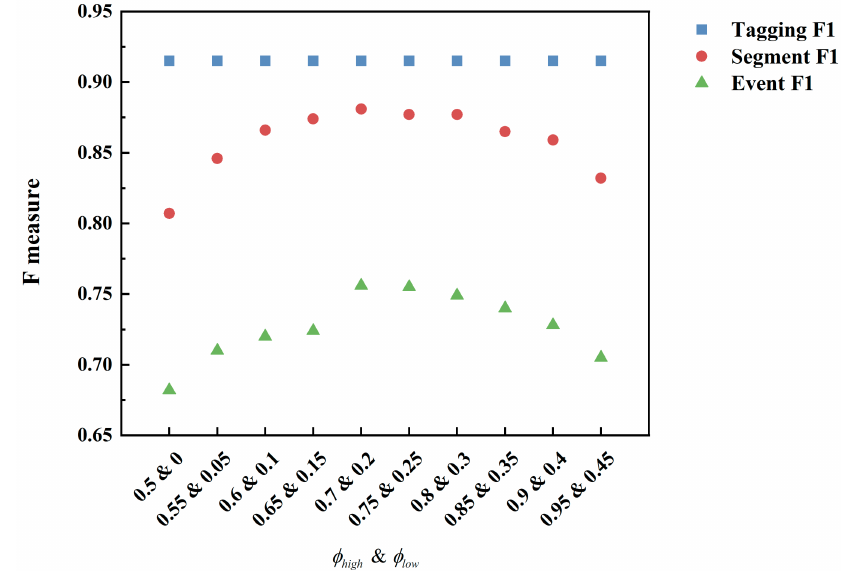
Figure 11. The prediction output and double thresholds. The horizontal axis in Figure 12 indicates the timing, the vertical axis represents the clip-level F1-scores, and the colored curves represent y t (𝑒) corresponding to distinct construction activities at a specific point. Using two thresholds to filter the output is more stable than a single threshold. φ high is used to set the minimum probability value for output, whereas φ low is used to obtain the event’s beginning and end boundaries. All predictions with values greater than φ high are considered valid. The searching is then shifted to neighboring locations in order to find those with values greater than φ low .